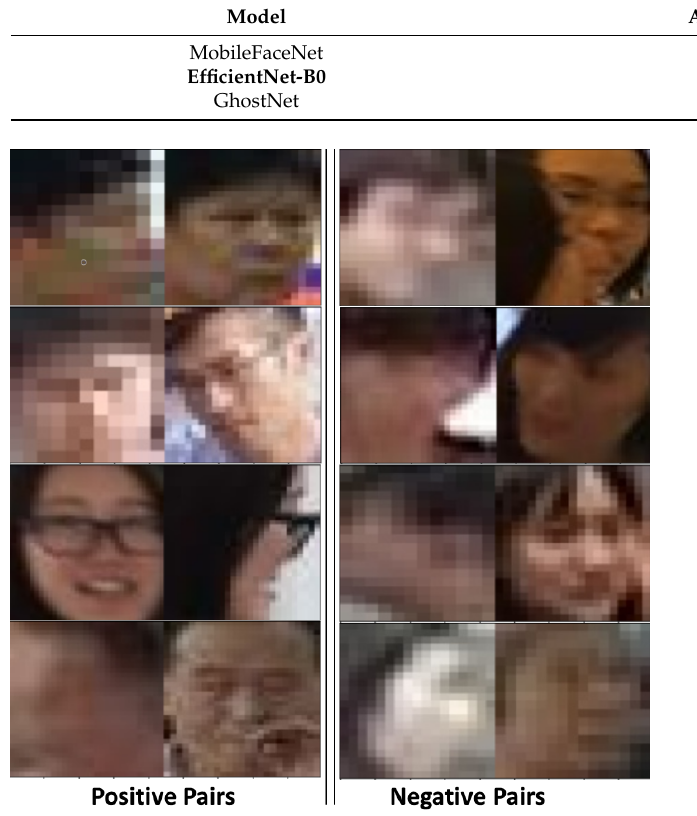
Figure 9. Example of QMUL-SurvFace image pairs incorrectly classified by EfficientNet-B0.